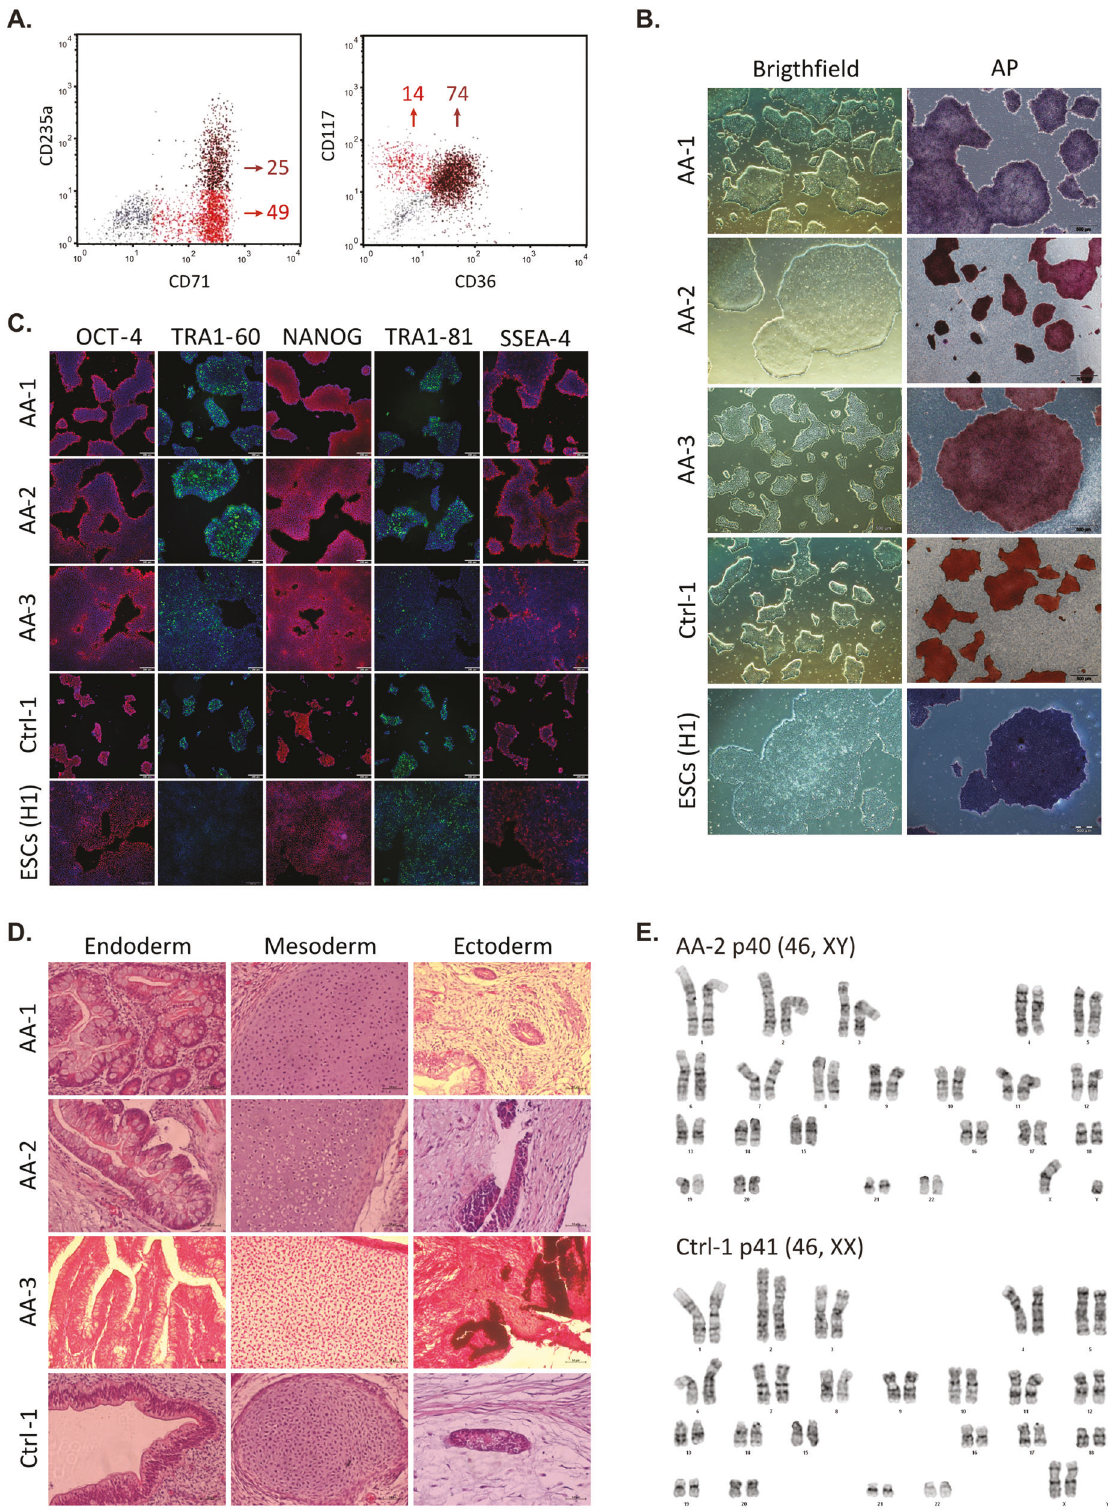
In order to screen for potential episomal plasmid DNA integration in the iPSCs, we veri fi ed the EBNA1 gene fragment ampli fi cation that is common to the eight reprogramming vectors used in this study. After 14 passages, EBNA1 was undetectable in all patient and control iPSC clones (Supplementary Fig. 1) [13]. Cytogenetic analysis by G-banding showed normal karyotypes